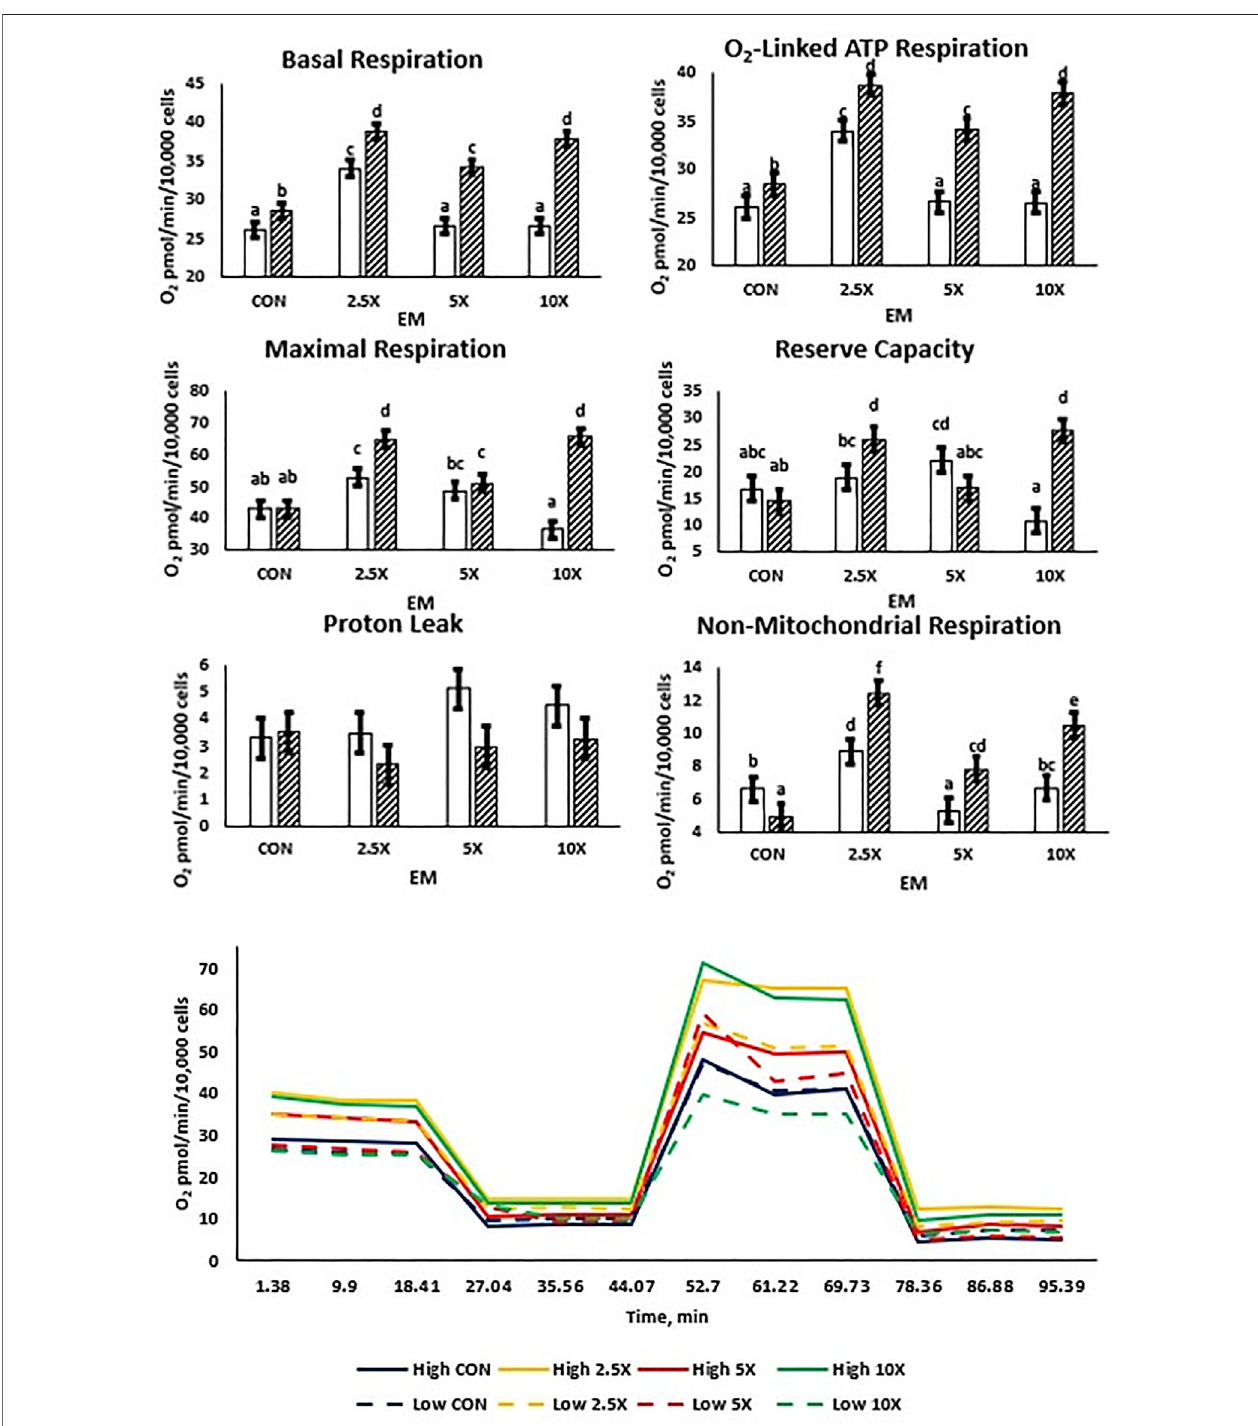
FIGURE 3 | Mitochondrial respiration increases cubically with supplementation of epigenetic modi fi ers (EM) in High but not in Low cells. Basal respiration and O 2 -linked respiration increase to ×2.5 in Low, but reserve capacity increases to ×5 in Low. Low glucose cells are represented by the solid white bar. High glucose cells are represented by the dashed bar. Means without a common superscript differ in glucose × EM ( p ≤ 0.05). Three replicates per treatment were measured (three technical replicates per biological replicate). Error bars represent the average standard error of the mean within a glucose level at each measurement.